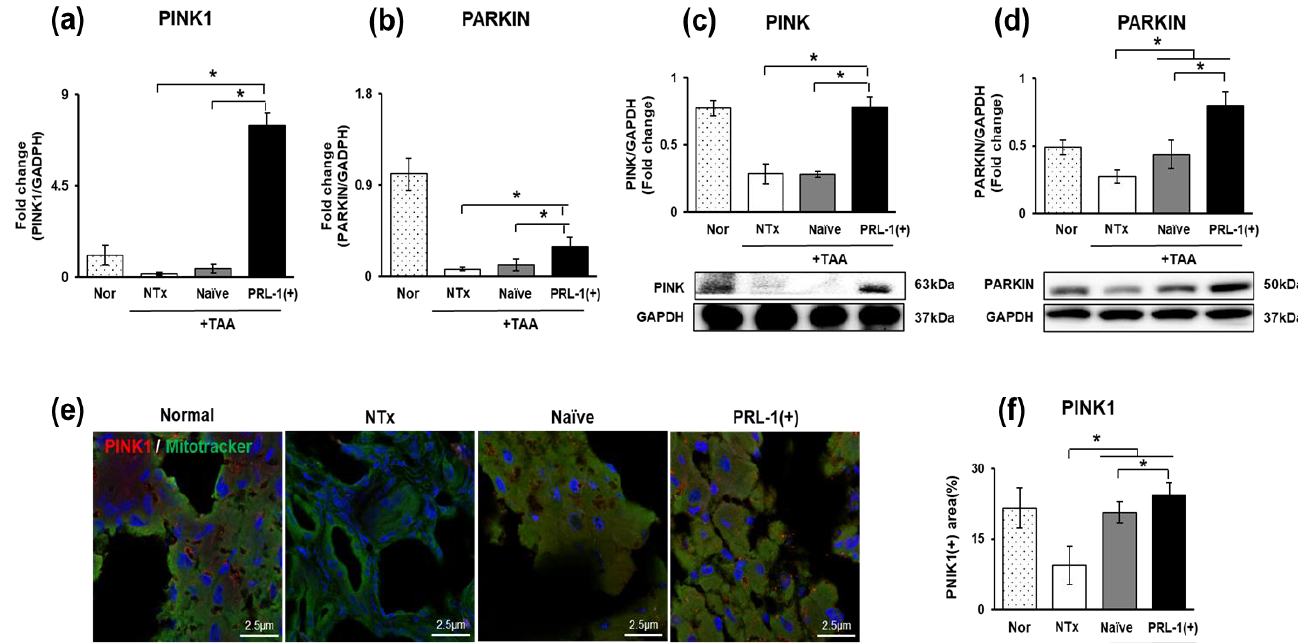
Figure 5. Regulation of mitophagy in TAA-injured rat livers. The expression of mitophagy in TAA-injured rat livers measured by qRT – PCR and Western blot ( a ) and ( c ) PINK1, ( b ) and ( d ) injured rat livers measured by qRT–PCR and Western blot ( a , c ) PINK1, ( b , d ) PARKIN. Localization of PARKIN. Localization of PINK1 in TAA-injured rat livers demonstrated by IF ( e ) and ( f ). All ex- PINK1 in TAA-injured rat livers demonstrated by IF ( e , f ). All experiments were repeated in duplicate periments were repeated in duplicate to triplicate. * p < 0.05. to triplicate. * p <